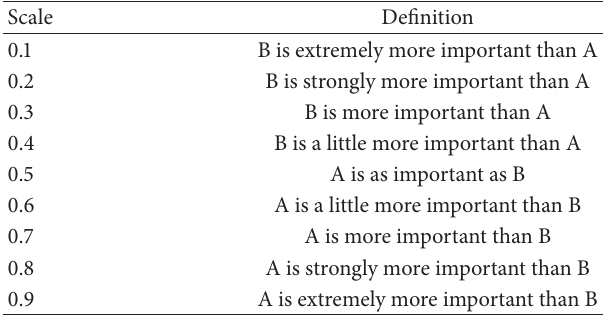
Table 5: Definition of 0.1–0.9 scale.